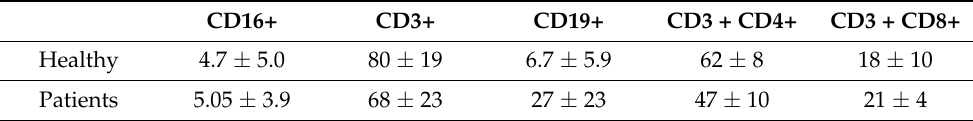
Table 2. Percentages of lymphocyte cell subsets in gingival tissues obtained from healthy individuals and periodontitis